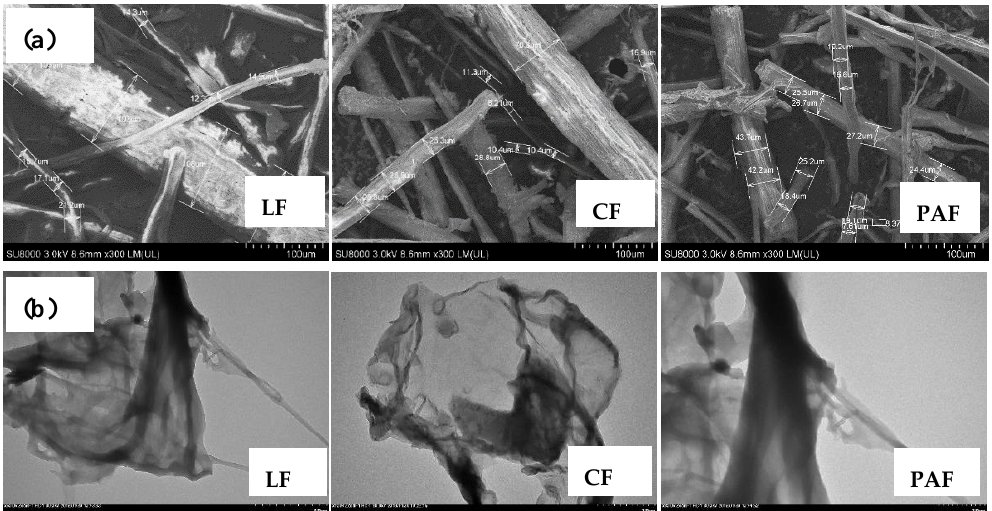
Figure 3. ( a ) SEM and ( b ) TEM images of linen fiber (LF) and its chlorite- (CF) and peroxyacetic acid- treated (PAF) forms acquired at a magnified view (300 ×